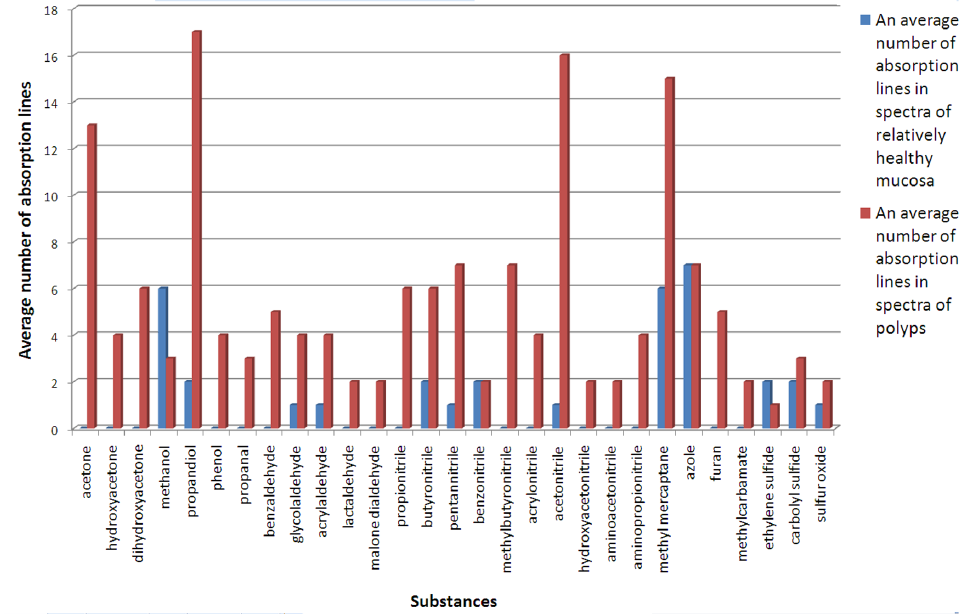
Figure 3. The chemical composition of the products of the thermal decomposition of polyp (red) and relatively healthy mucosa (blue) samples.